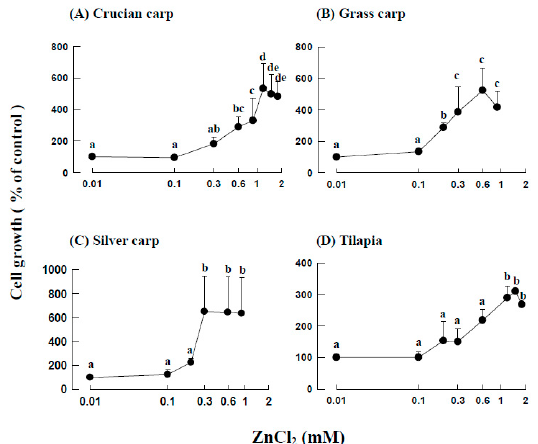
Figure 2. Effects of ZnCl 2 concentrations on erythropoiesis in fish head kidney cells: ( A ) crucian carp, ( B ) grass carp, ( C ) silver carp, and ( D ) tilapia. The fish head kidney cells were suspension cultured with 0.01 (control), 1.0, or 1.8 mM ZnCl 2 in the presence of 10% fish serum. Measurement of the cell growth is described in Materials and Methods. The results are the means ± SDs of six independent experiments. Values with different letter superscripts are significantly different at p < 0.05.